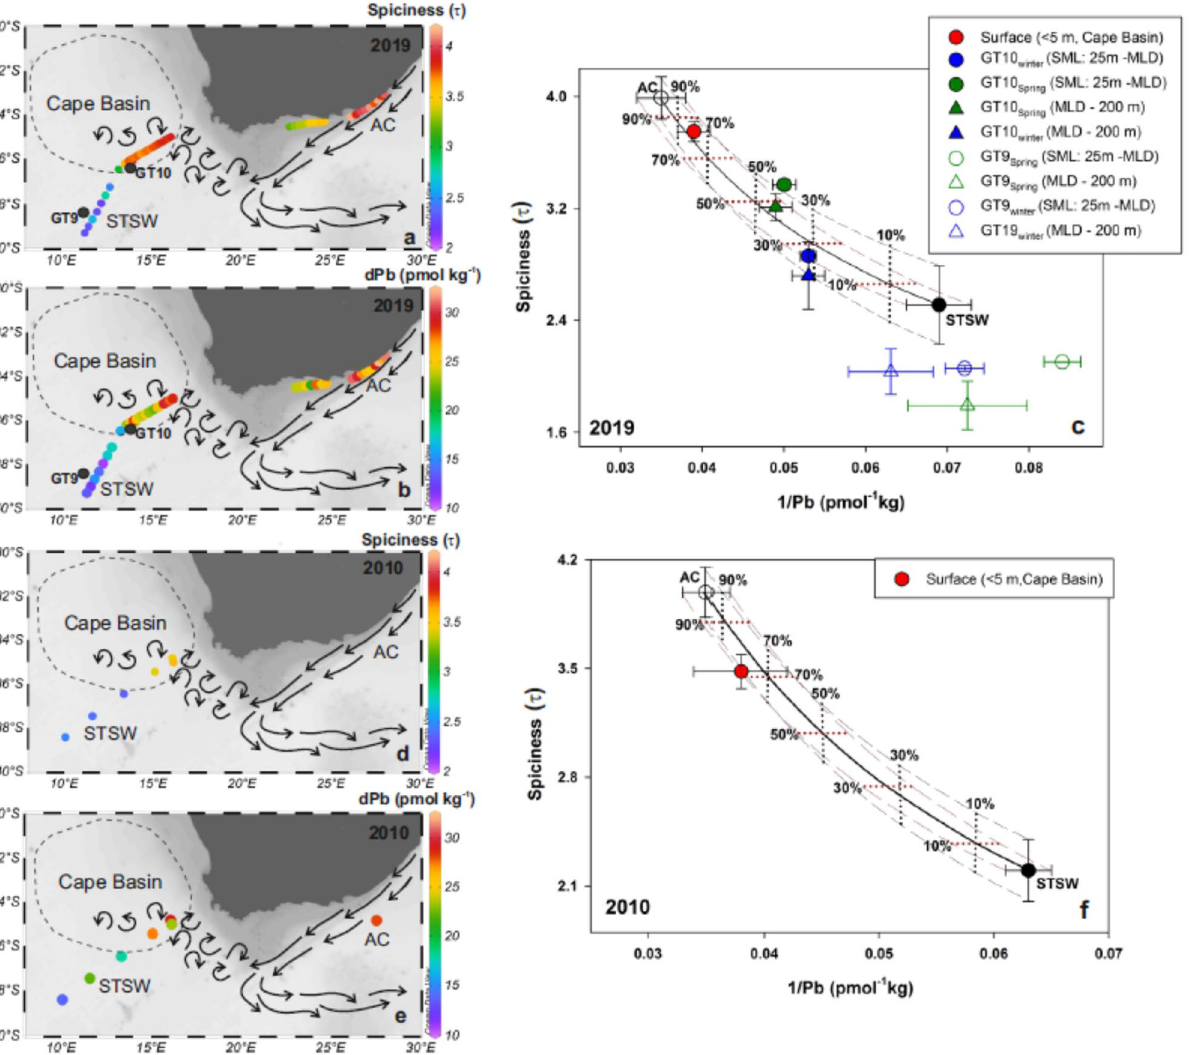
Figure 2. Distribution of τ ( a ) and dPb ( b ) in the Subtropical oceans around South Africa in 2019. ( c ) The mixing diagram of dPb was made using the data presented in the a and b panels. Distribution of τ ( d ) and dPb concentration ( e ) in 2010 from published literature 28,35 and the corresponding mixing diagram ( f ). The arrows show the idealised circulation patterns. The end members (τ and Pb) for AC (open circle) and STSW (black-filled circle) in the mixing plots were calculated from the average and standard deviation of the samples collected in different oceanic regions representing the respective water masses shown in the left panels. The bold black curve in the mixing diagram ( c and f ) indicates the mixing between absolute values of the two end- members. The dashed curves also indicate the mixing considering the standard deviation associated with the absolute values of the end-members (black corresponds to τ and brown corresponds 1/Pb). The dotted lines represent the contribution of AC water constructed considering both the range of τ (black) and 1/Pb (brown). The τ value for the AC in 2010 ( f ) was drawn based on the 2019